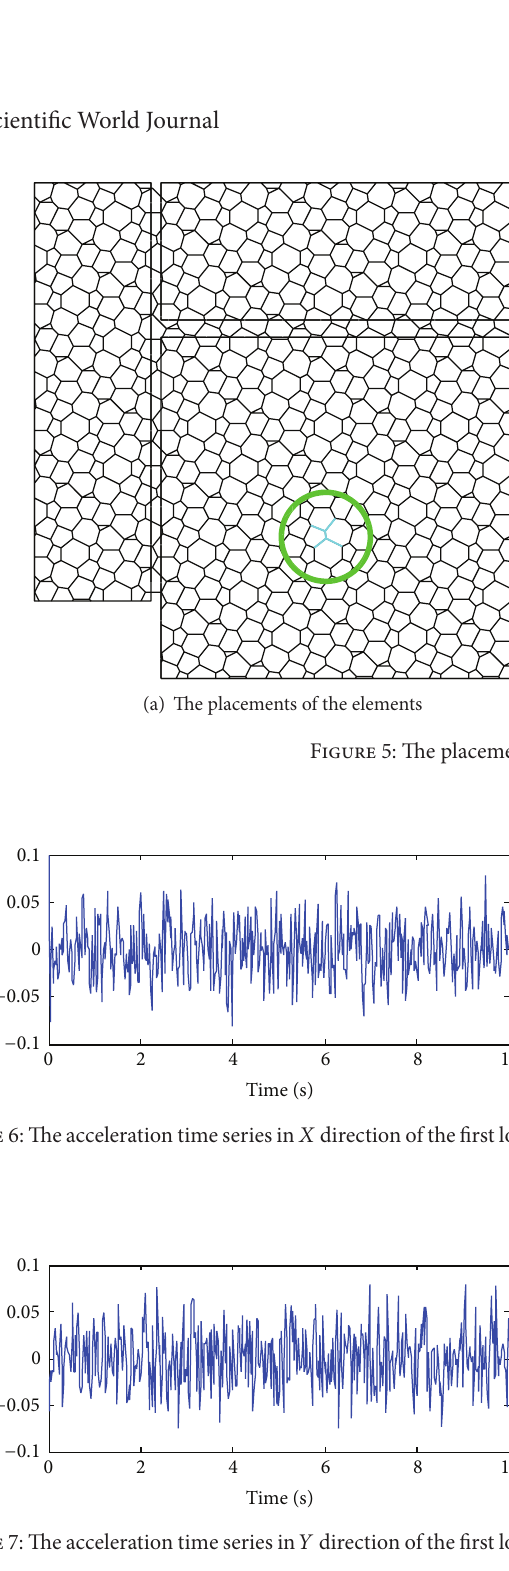
Figure 7: The acceleration time series in 𝑌 direction of the first load case.